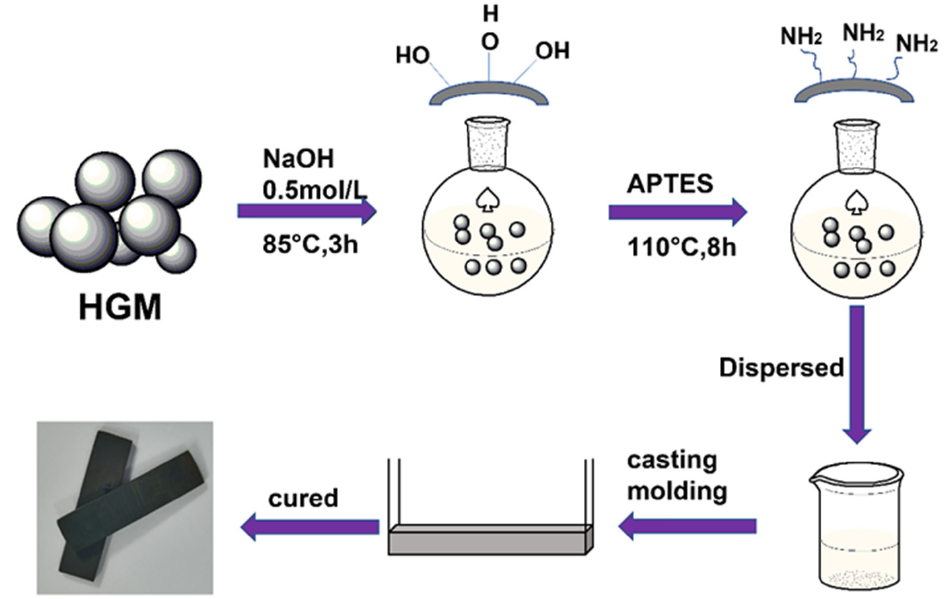
Figure 1. The preparation procedures of modified particles and PBDP/HGM-NH 2 composites.